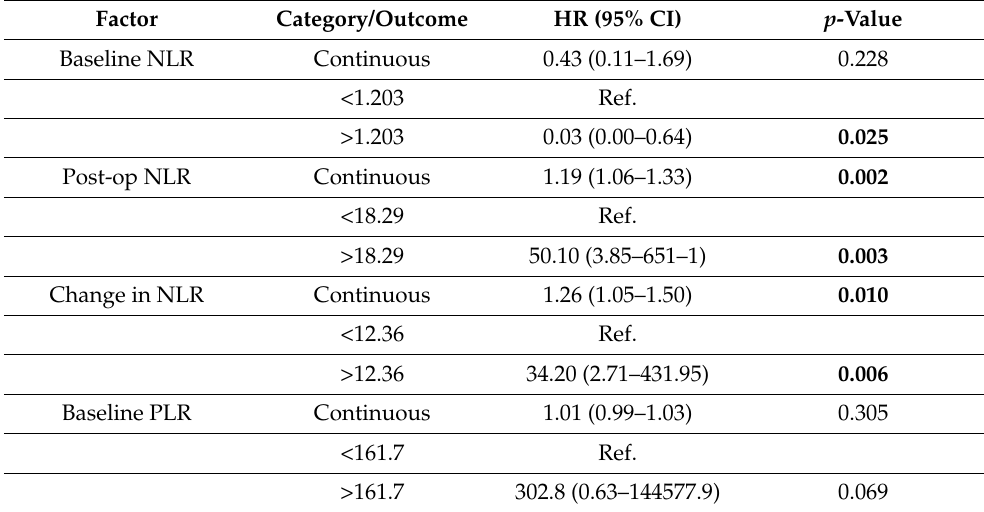
Table 4. Multivariable analysis of NLR and PLR for cancer-speci fi c survival.